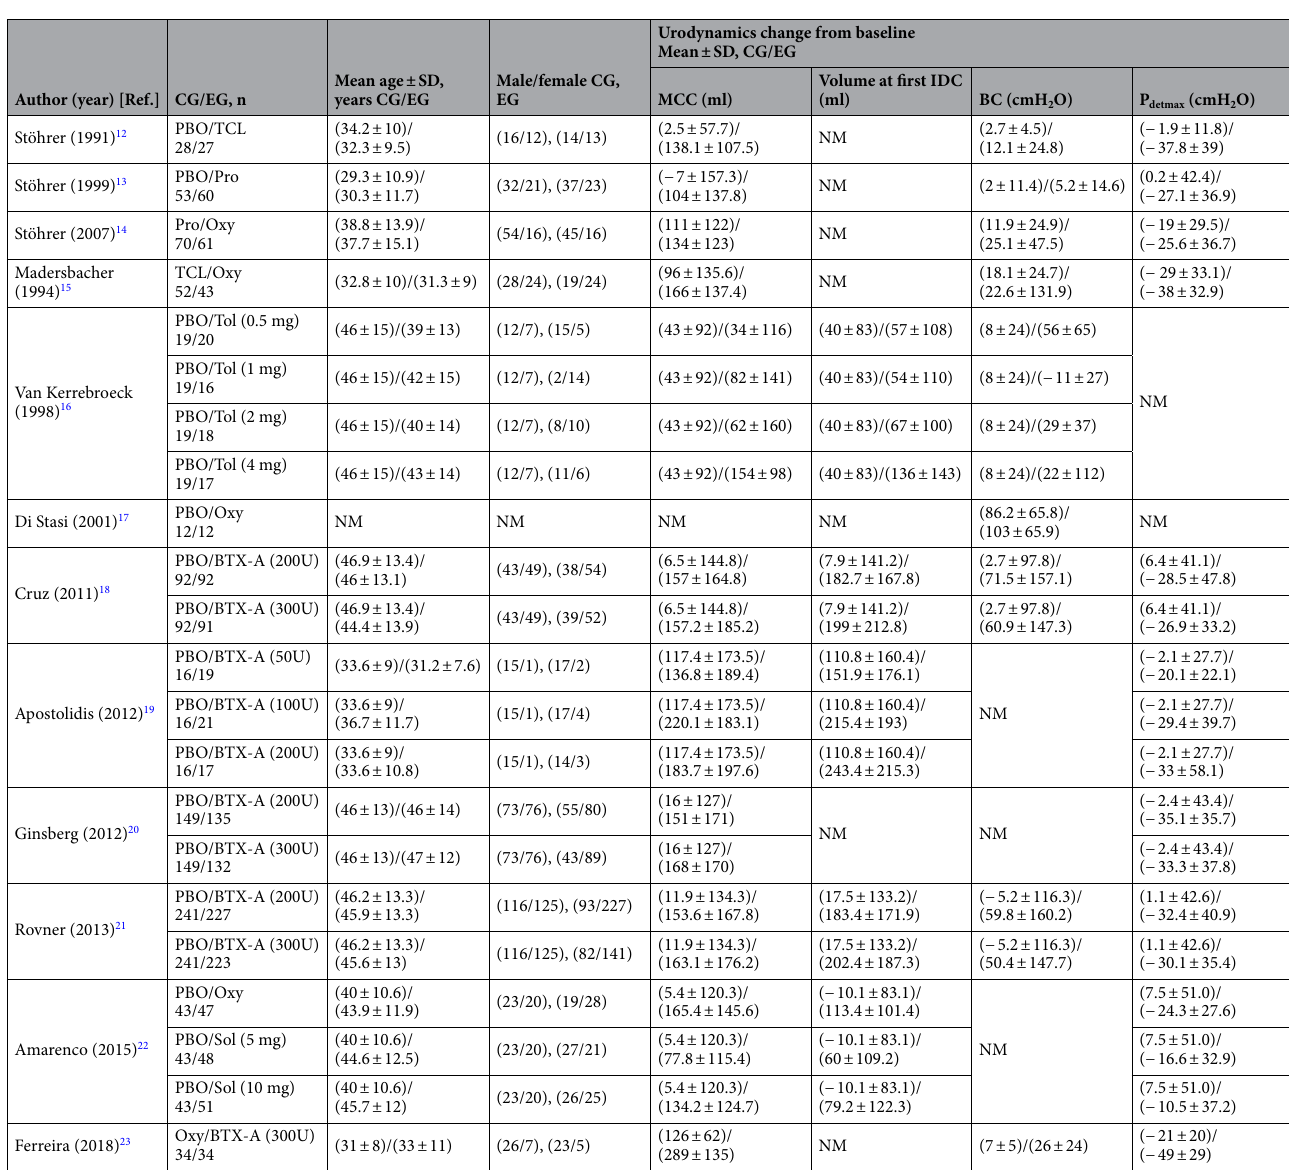
Table 2. Baseline population characteristics of included studies. CG control group, EG experimental group, NM not mentioned, MCC maximum cystometric capacity, IDC first involuntary detrusor contraction, BC bladder compliance, Pdet max maximum detrusor pressure, PBO placebo, TCL trospium chloride, Pro propiverine, Oxy oxybutynin, Tol tolterodine, BTX-A onabotulinumtoxinA, Sol